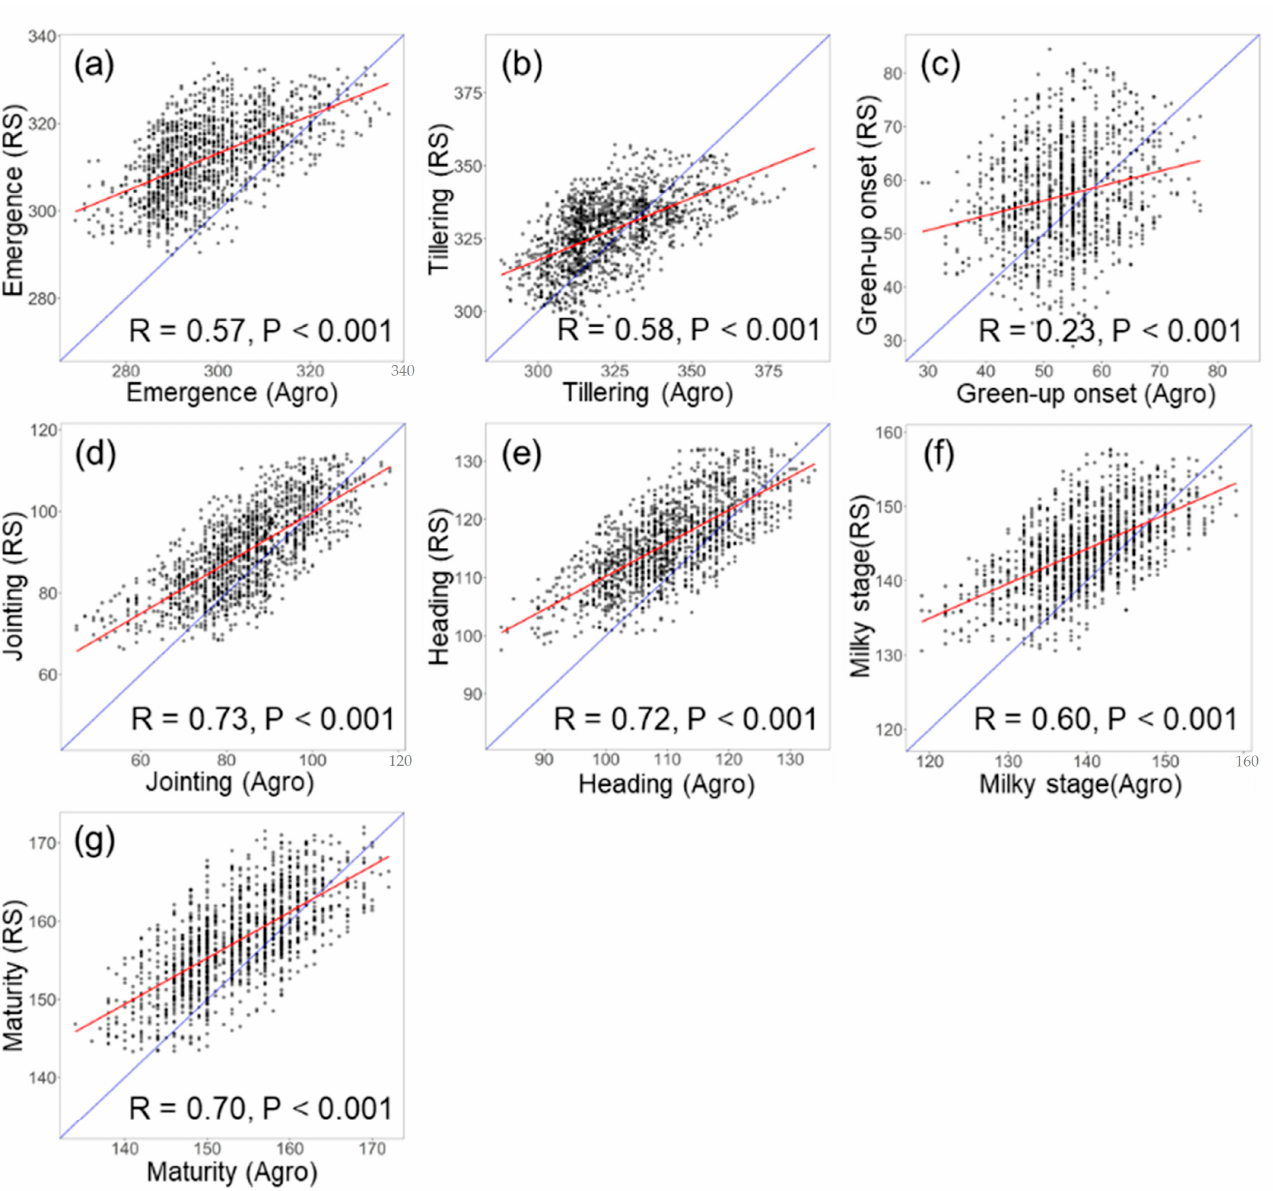
coefficient was highest for the jointing date (R = 0.73), followed in descending order by the